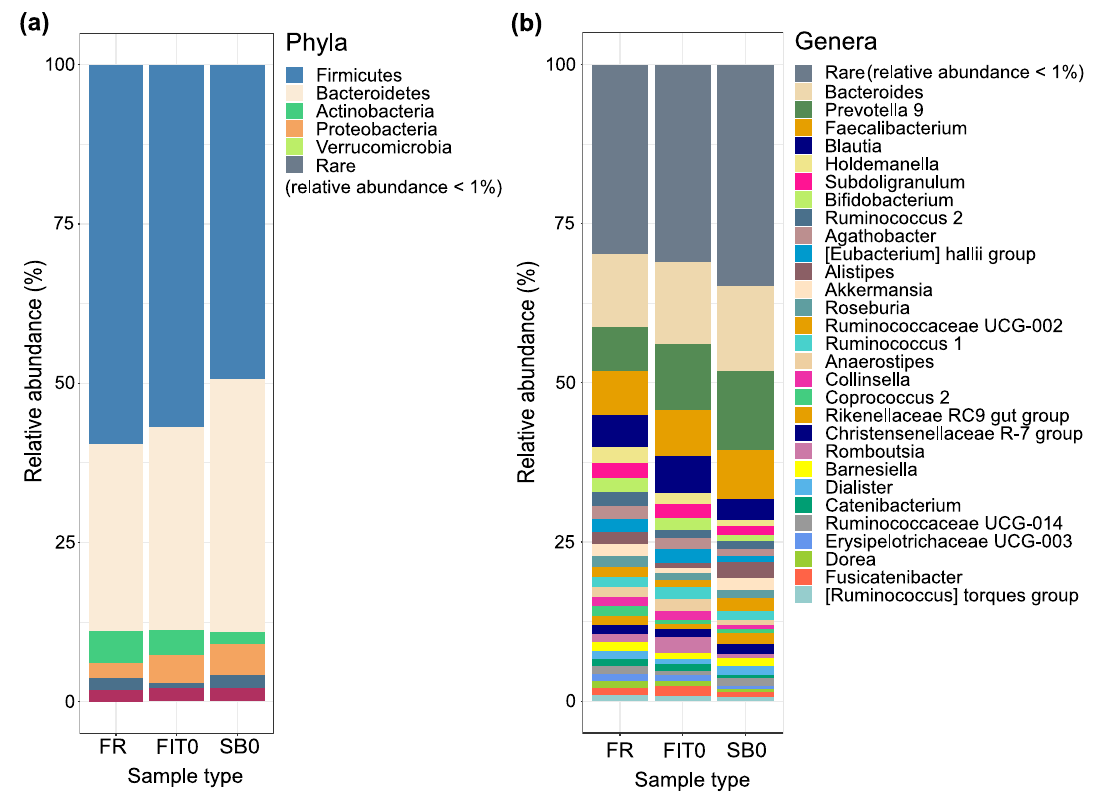
Figure 2. Relative abundance of phyla ( a ) and genera ( b ) under different collection methods on day 0. Taxa with a mean relative abundance of less than 1% were grouped into the rare category. FR fresh-frozen; FIT0 immediately frozen FIT samples; SB0 immediately frozen stabilization buffer